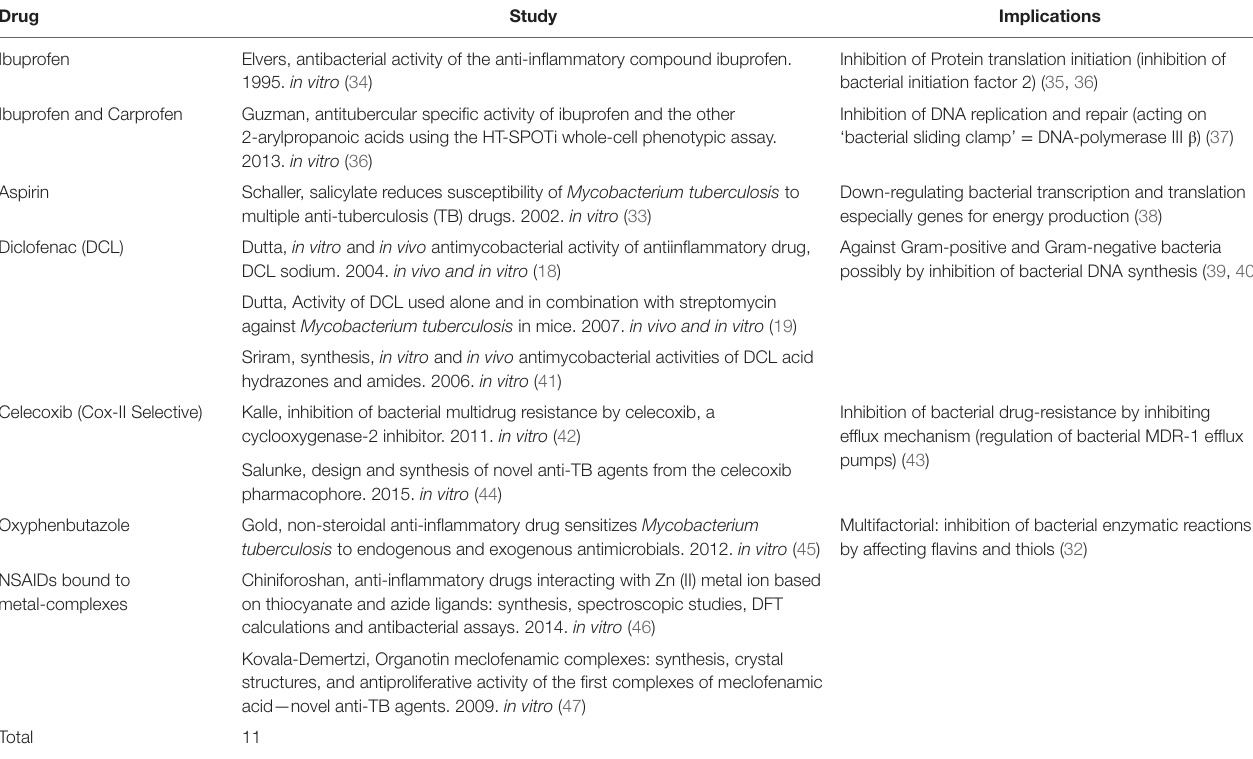
TAbLe 3 | Non-steroidal anti-inflammatory drugs (NSAIDs) acting as anti-tubercular non-antibiotics (including in vitro studies). Drug Study